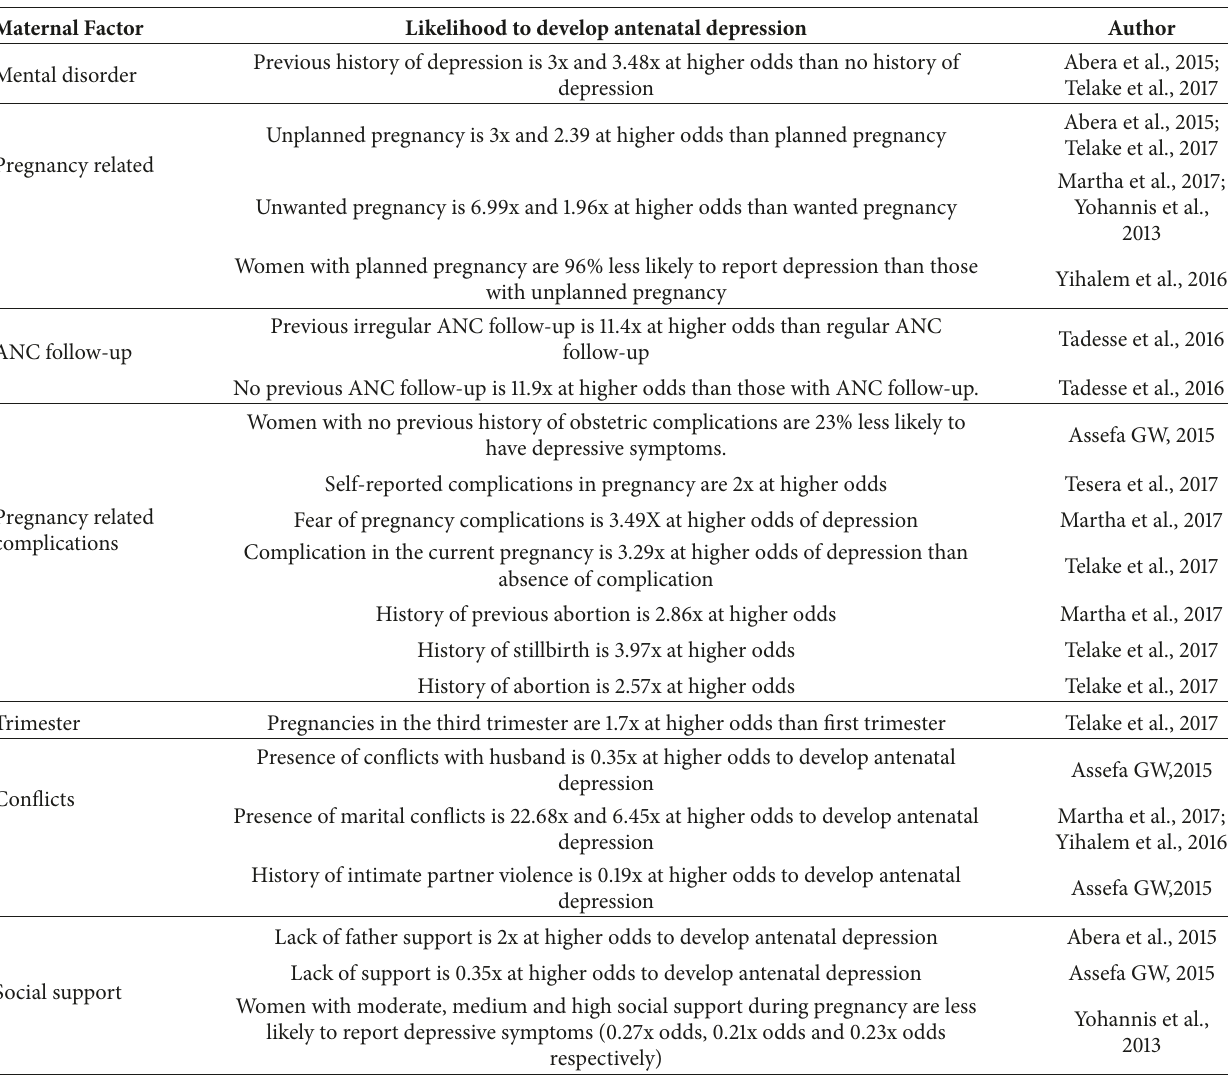
Table 4: Maternal risk factors for antenatal